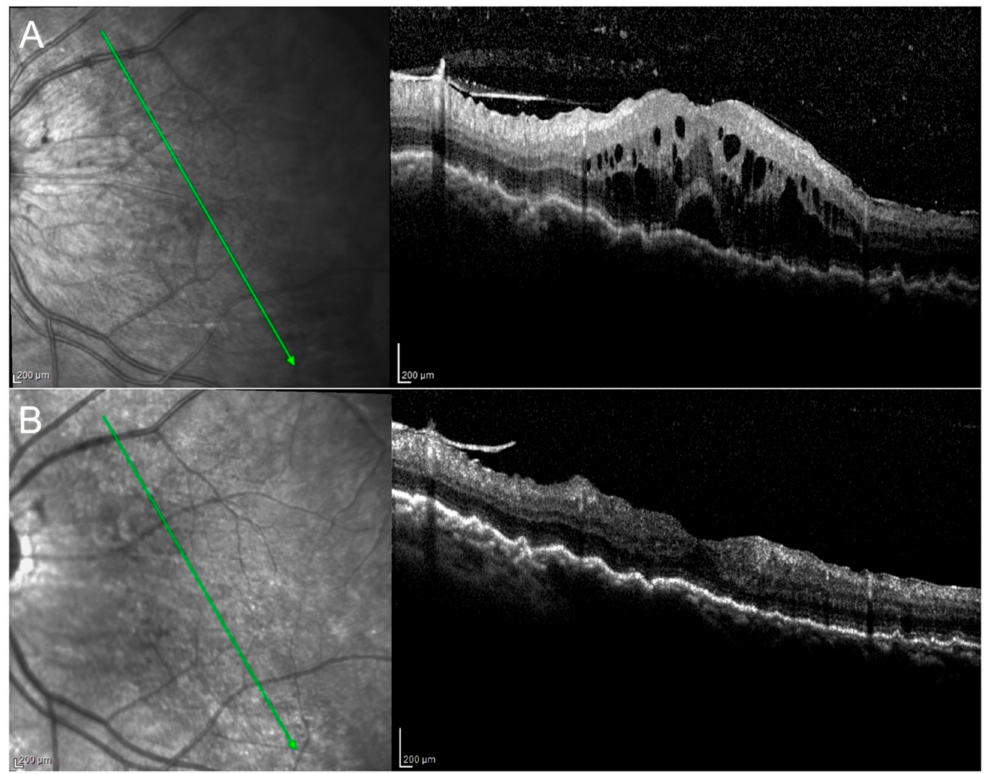
Figure 1. Birdshot retinopathy. Picture at baseline ( A ) shows the presence of macular edema and choroidal folds, which decreased at M3 ( B ). Vitritis ( A ) resolved at M3 ( B ). Results of the ophthalmic examination, OCT, and FA (presence of epiretinal membrane, retinal hyperreflective spots, papillitis, vitritis) are summarized in Table 4, and some selected examples can be seen in Figures 2–4. Granulomas were described at M0 in the patient a ff ected by sarcoidosis and disappeared at M3. There was a significant reduction of vasculitis (number of quadrants a ff ected) from M0 to M > 12 with a p -value of 0.01 (Table 3; Figure